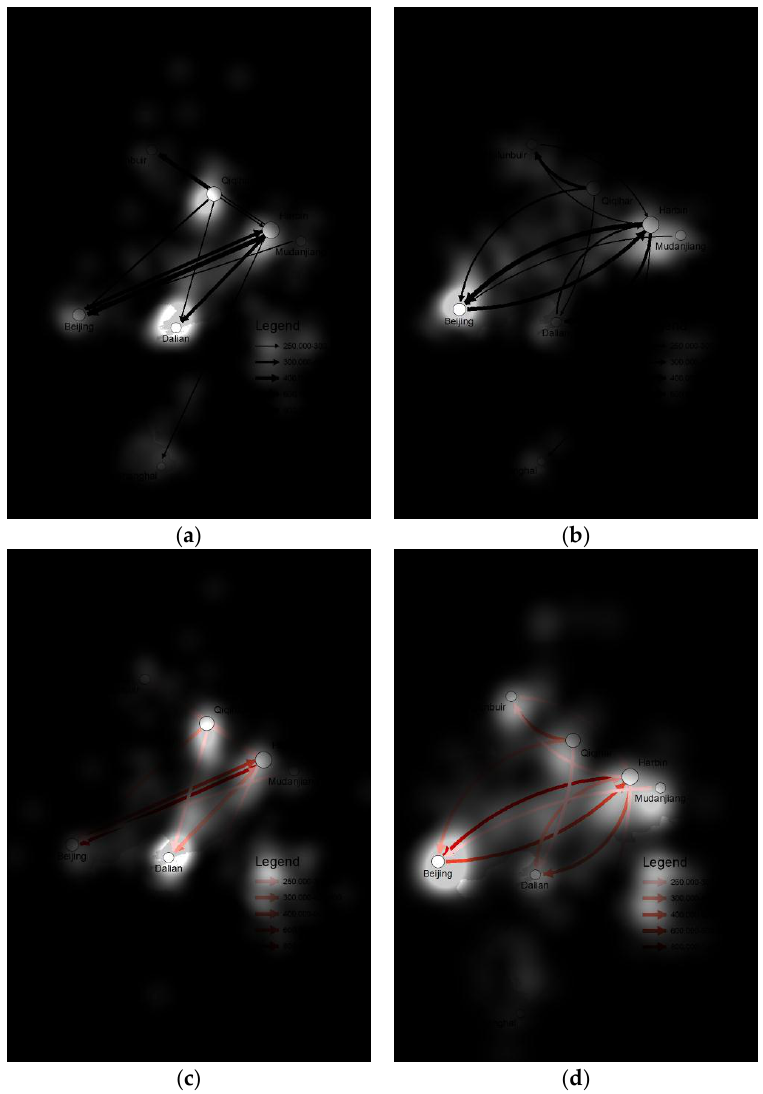
Figure 6. Samples of gaze opacity maps (generated by the fixation count of all participants with a radius of 50 pixels in Tobii Studio). SL = straight line; CV = curve; LT = line thickness; and CG = color gradient. ( a ) SL + LT ; ( b ) CV + LT ; ( c ) SL + CG ; and ( d ) CV + CG .